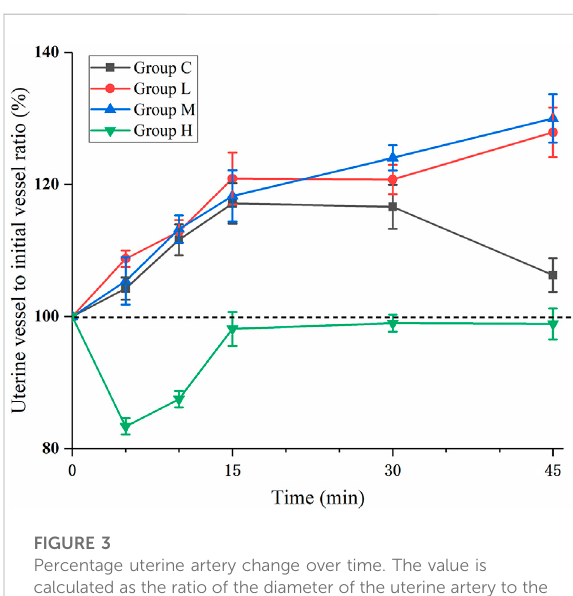
FIGURE 3 Percentage uterine artery change over time. The value is calculated as the ratio of the diameter of the uterine artery to the initialdiameterateachtimepoint.InGroupH,thevaluedecreased rapidly and reached its nadir after 5 min ( p < 0.05 compared with C, L, and